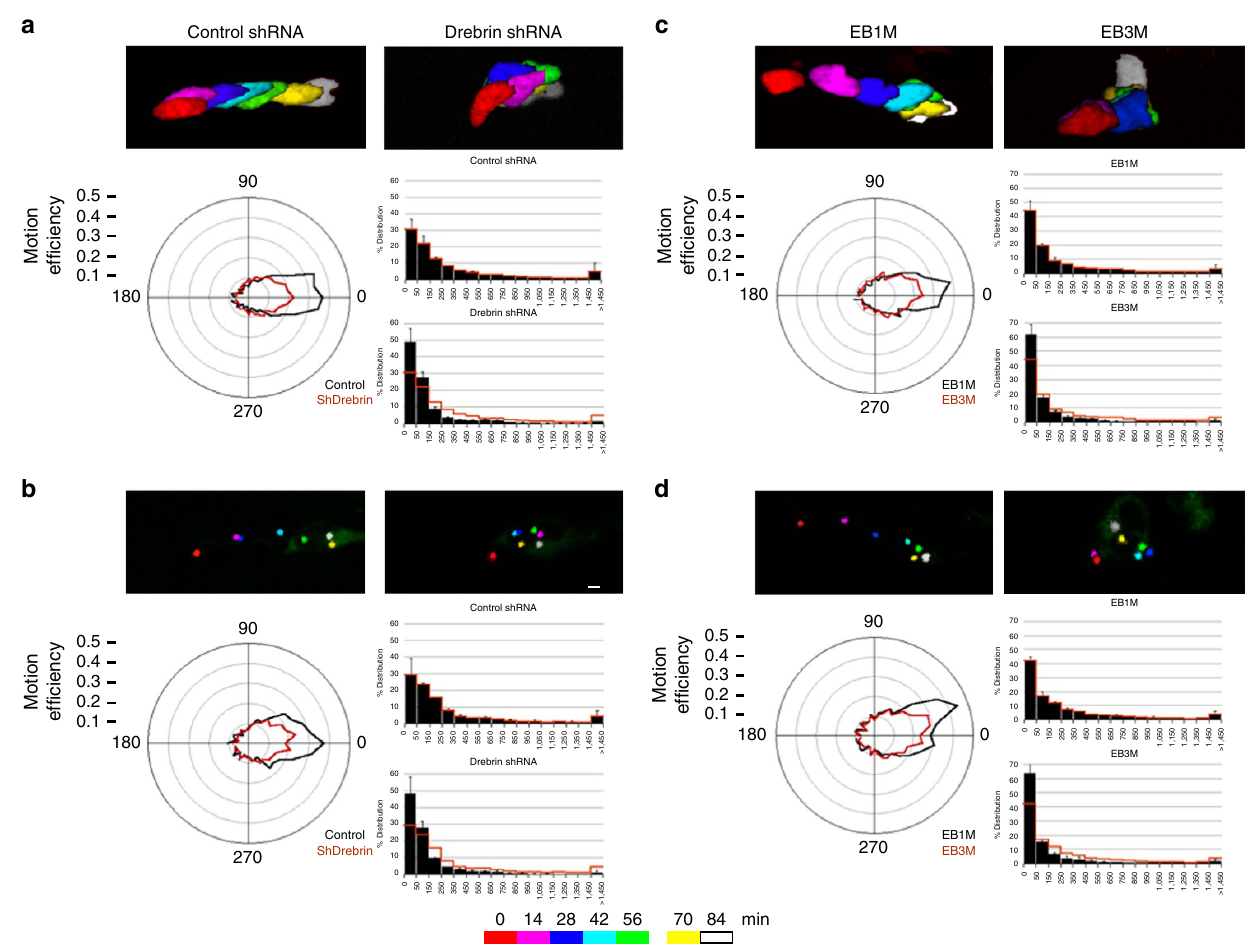
Figure 5 | Drebrin function is required for directed movement of two-stroke motility in vitro . CGNs were transfected with expression vectors encoding Centrin2-Venus, H2B-mCherry and the indicated experimental constructs. Time-lapse imaging was used to monitor two-stroke nucleokinesis in migrating CGNs in which drebrin was silenced ( a , b ) ( n Z 57 cells analysed for each condition and organelle) or when the dominant-negative EB3M was overexpressed ( c , d ) ( n Z 70 cells analysed for each condition and organelle). The multicolour images in a , c show nuclear positions for selected time points from representative imaging sequences, whereas b , d show centrosome positions (see the colour key for time points). A polar efficiency and an MSD plot are provided for each organelle. Drebrin loss of function and dominant-negative inhibition of plus-end binding is accompanied by less efficient somal and centrosome motility relative to calculated FDVs. Scale bars, 10 m m. Error bars show ±